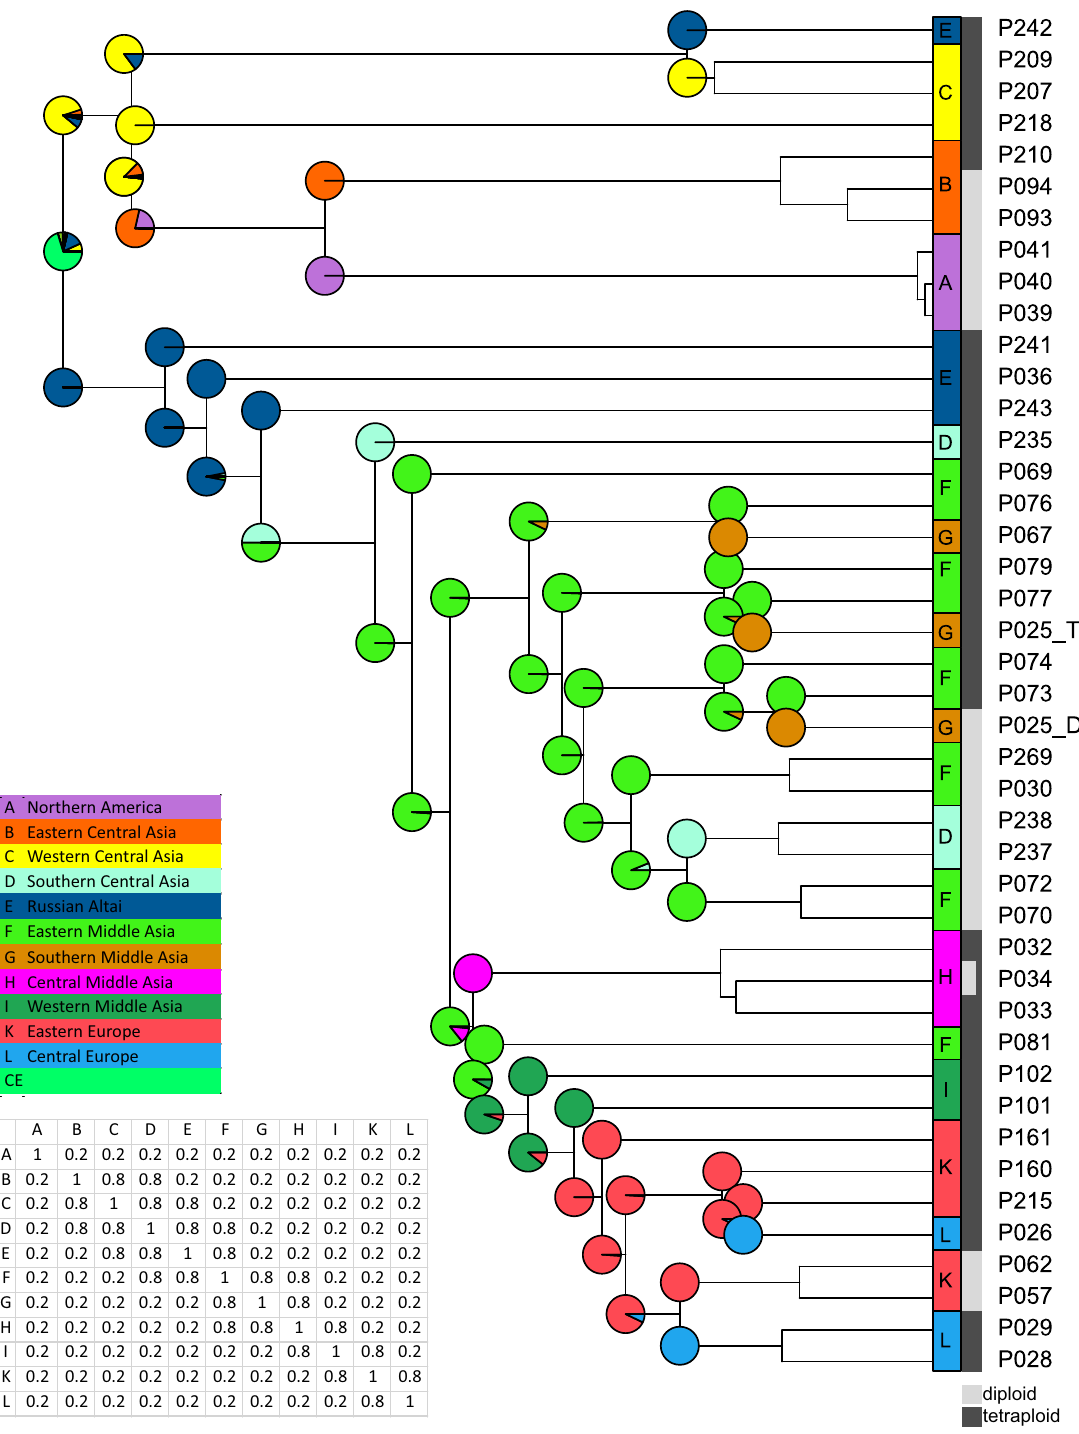
Figure 7. Phylogeographic analysis using the DIVALIKE model of the R package BioGeoBEARS. Colours indicate the origin of the samples, compare Fig. 1. Branches were collapsed when several members of the same populations clustered together. Krascheninnikovia spread from the Altai Mountains to the East, reaching eastern Central Asia and North America, and to the West, reaching Middle Asia and Europe. The figure was generated in R and edited in Inkscape v1.0.2 (https:// inksc ape.